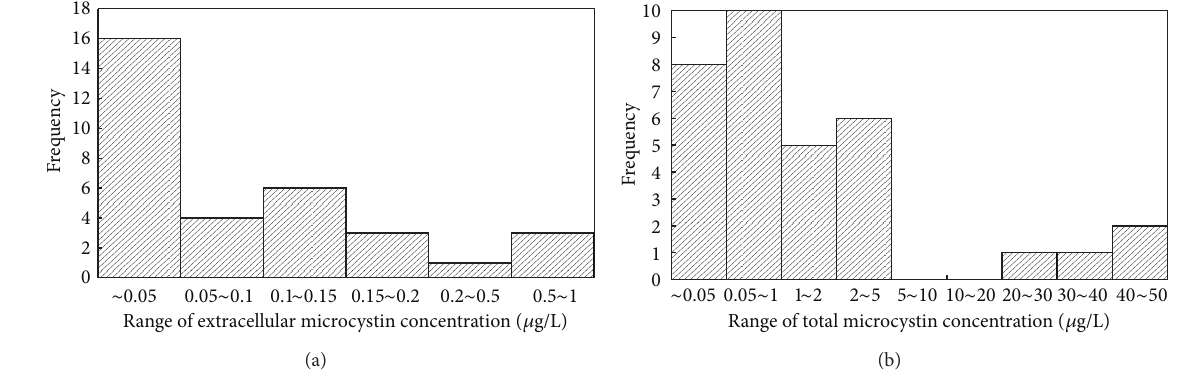
Figure 2: Frequency distributions of total cellular and extracellular microcystins.